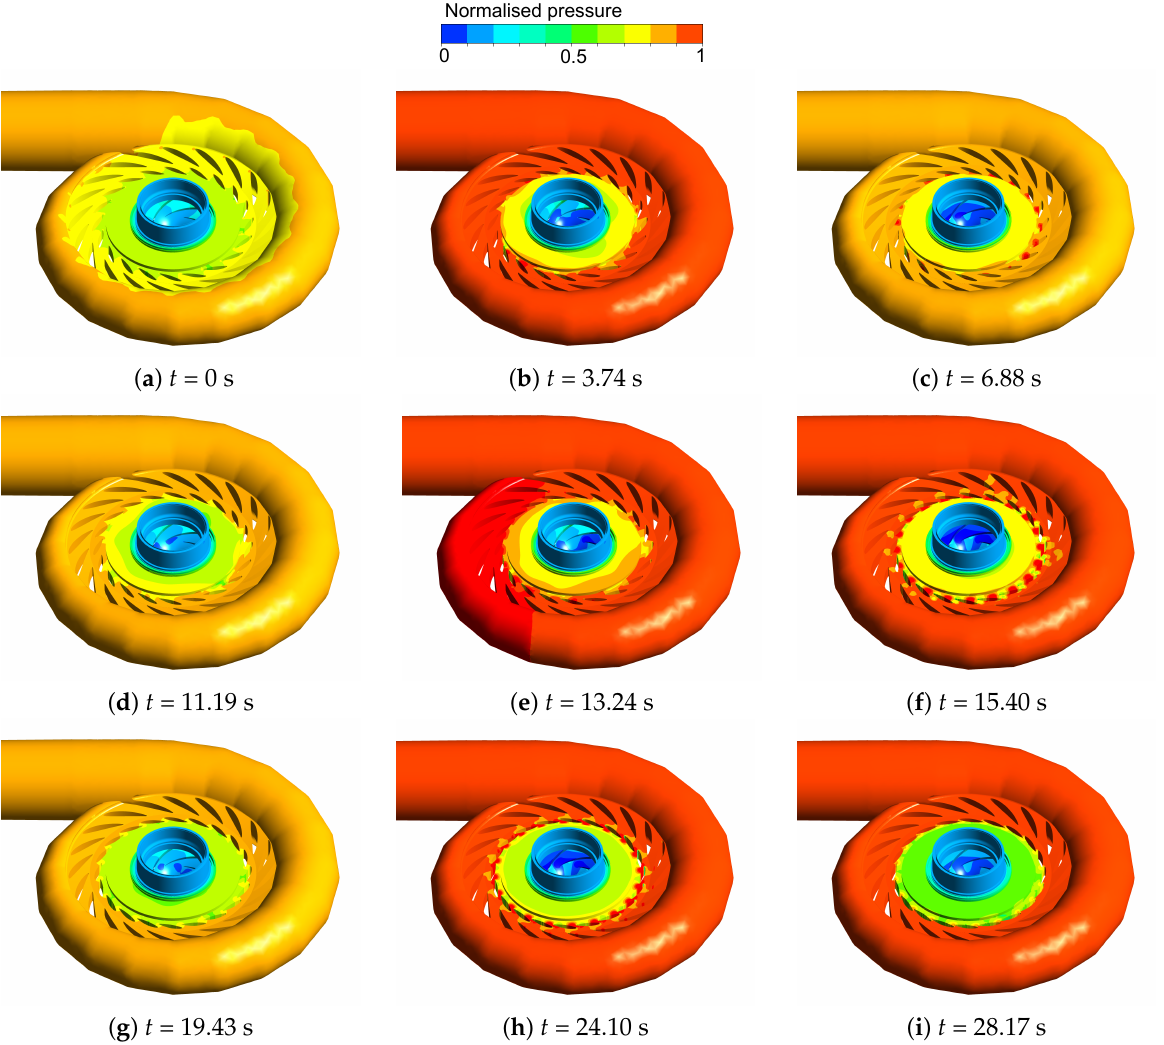
Figure 10. Pressure distribution in the flow passages at different key time